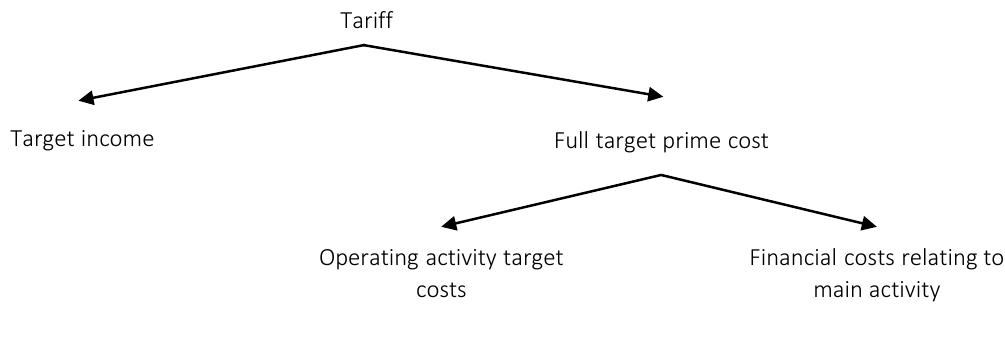
Figure 1. Scheme for forming the tariff for housing and utilities services